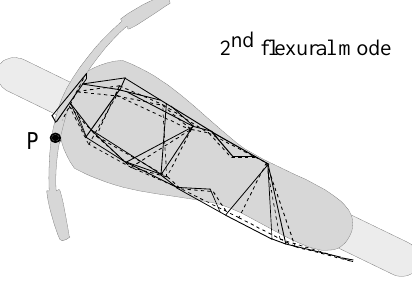
Fig. 10. Vehicle A, flexural mode, frequency 40.9 Hz, hysteretic damping 6.9%.